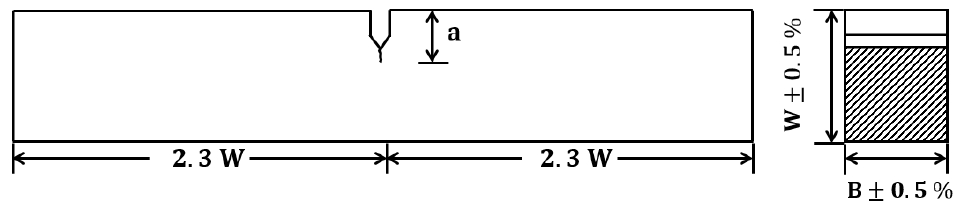
Figure 2. CTOD test specimen. Reprinted with permission from Ref. [2]. 1991, BSI.